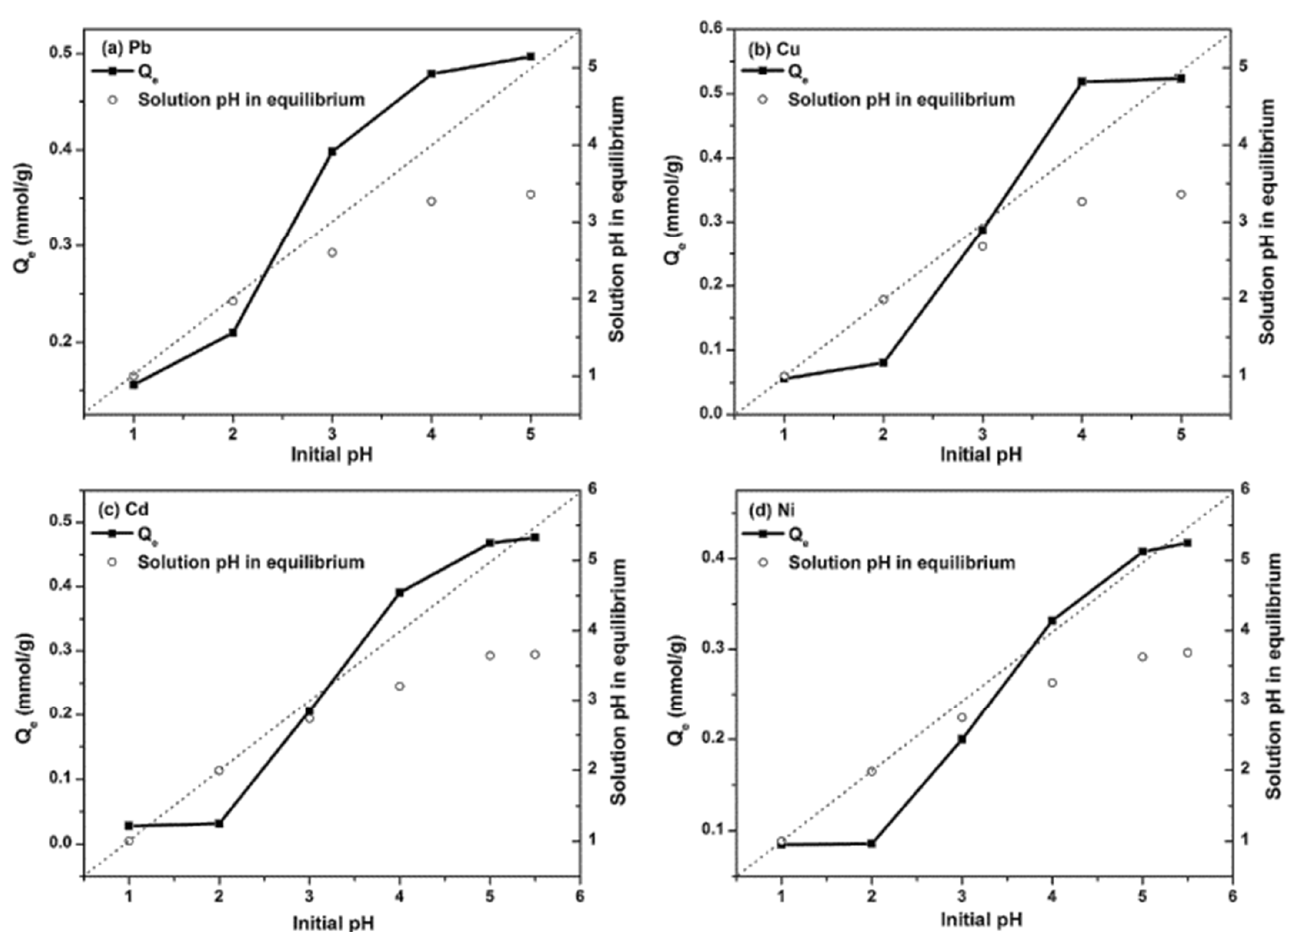
Figure 4. pH solution correlation with adsorption capacity of Cd 2+ , Pb 2+ , Cu 2+ , and Ni 2+ . Adapted with permission from